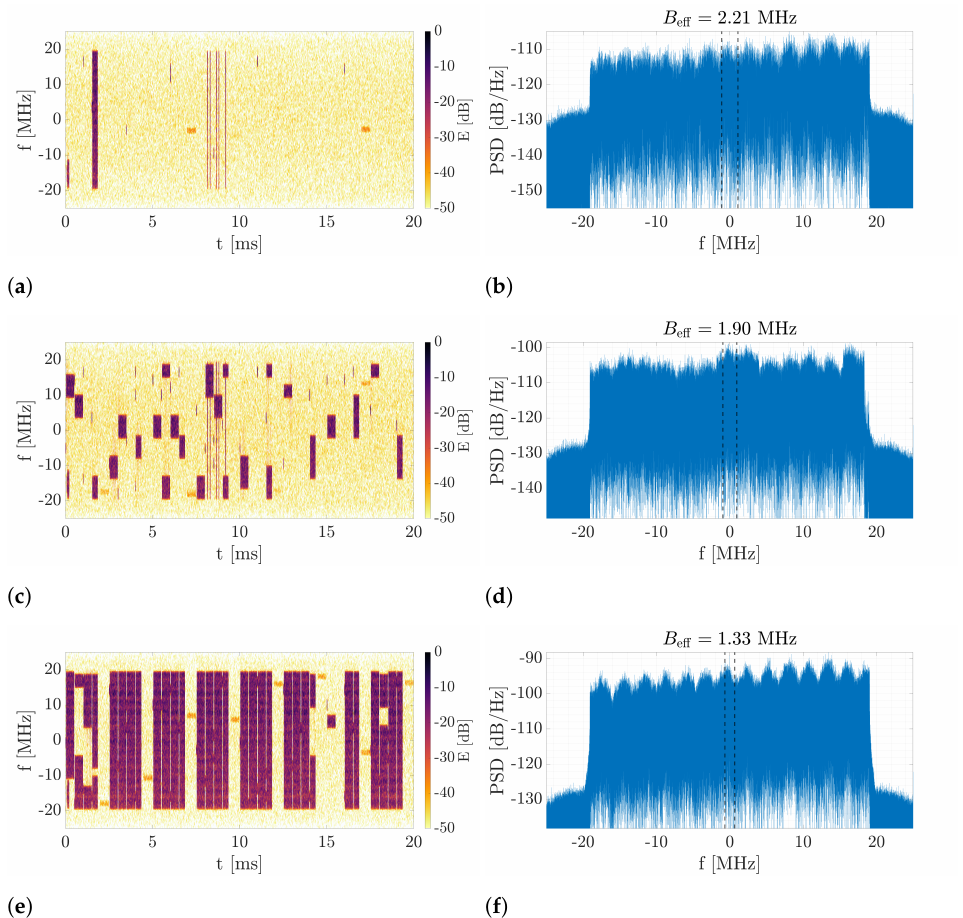
Figure 11. Evaluation of RMS effective bandwidth method. Spectrograms and PSD plots for different amount of content in real-life 5G signal. ( a ) Spectrogram for almost no content. ( b ) PSD for almost no content. ( c ) Spectrogram for medium amount of content. ( d ) PSD for medium amount of content. ( e ) Spectrogram for large amount of content. ( f ) PSD for large amount of